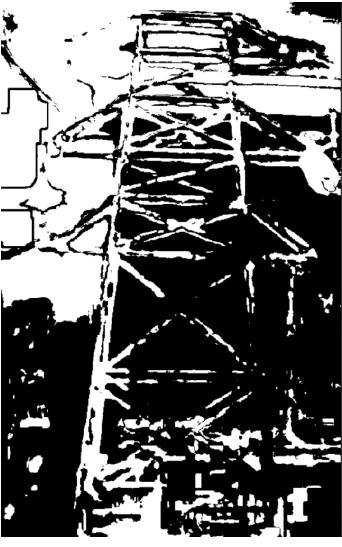
Figure 5. Mask the result.